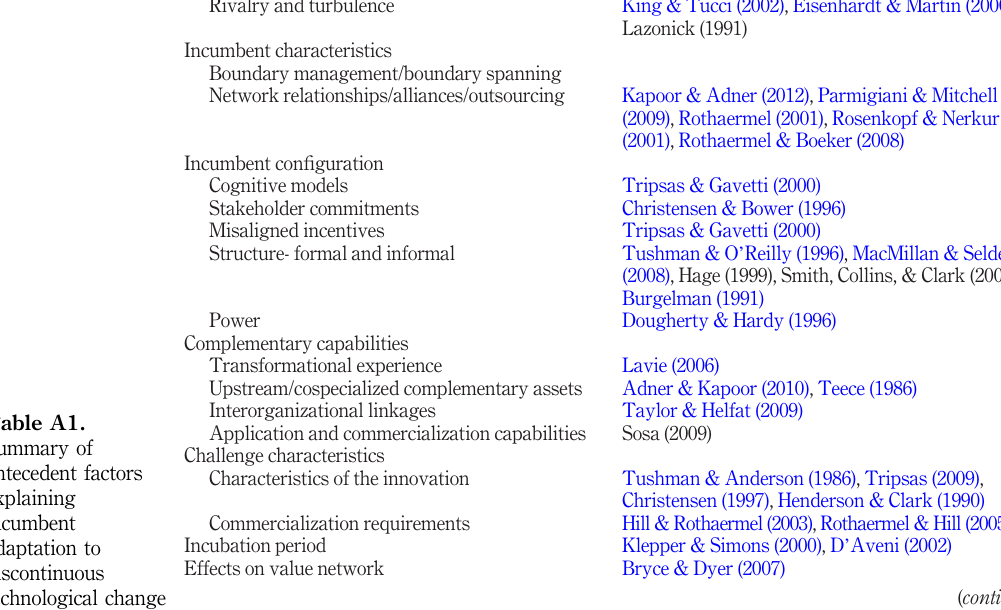
Table A1. Summary of antecedent factors explaining incumbent adaptation to discontinuous technological